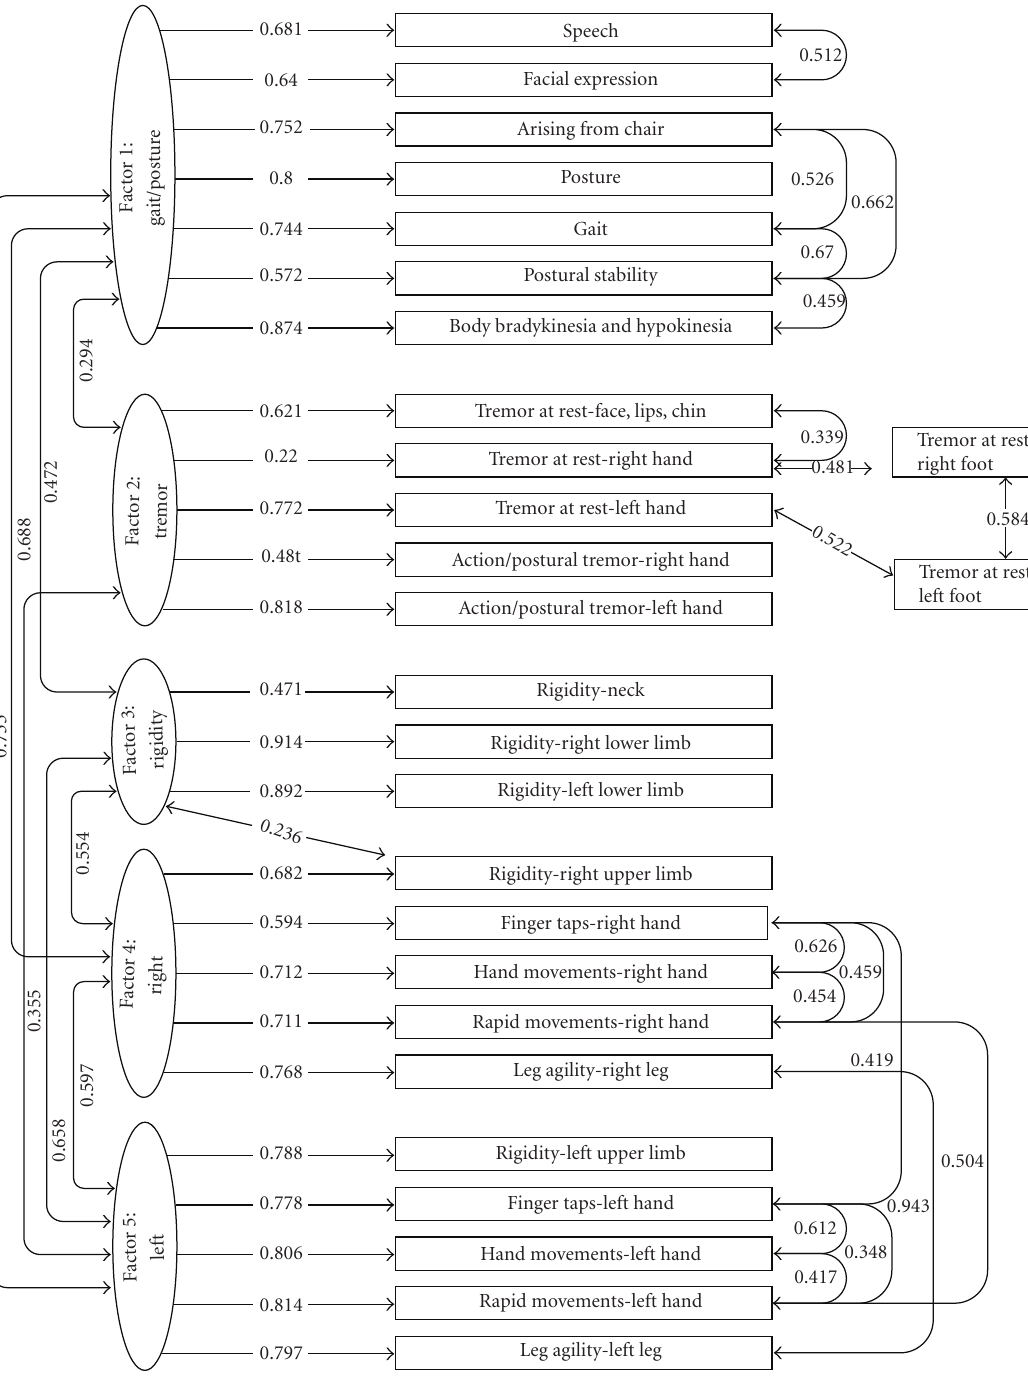
severity of PD symptoms. Mean scores on the motor UPDRS total and subscales were compared across response levels of each item. One-way ANOVA F-statistics were computed for each scale, and the significance of di ff erences between pairs of groups was estimated using Duncan’s multiple range test. We